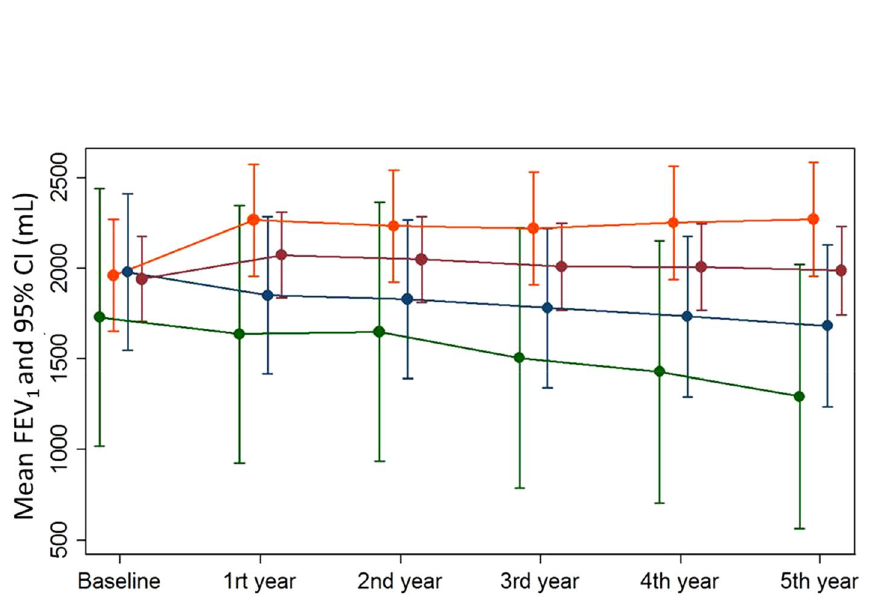
Table 3. FEV 1 response to sirolimus in 27 patients treated with sirolimus for 5 years. Data are shown as Mean (95% CI).